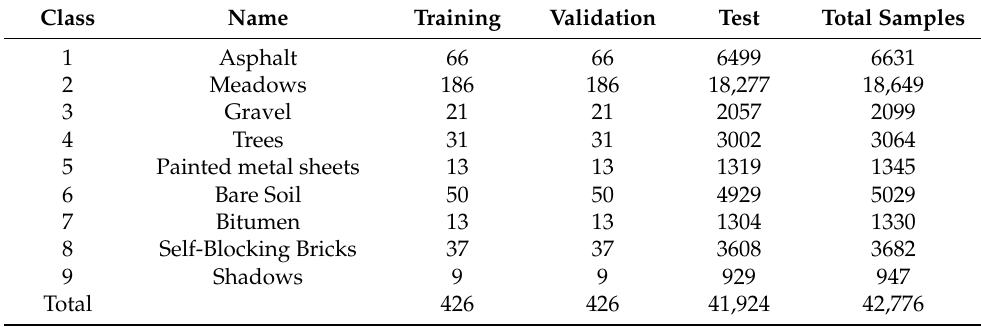
Table 2. Number of training, validation, and testing samples for the UP dataset.